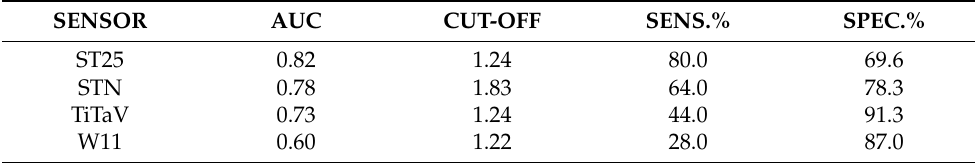
Table 2. Sensor performances on the basis of the ROC analysis. SENSOR AUC